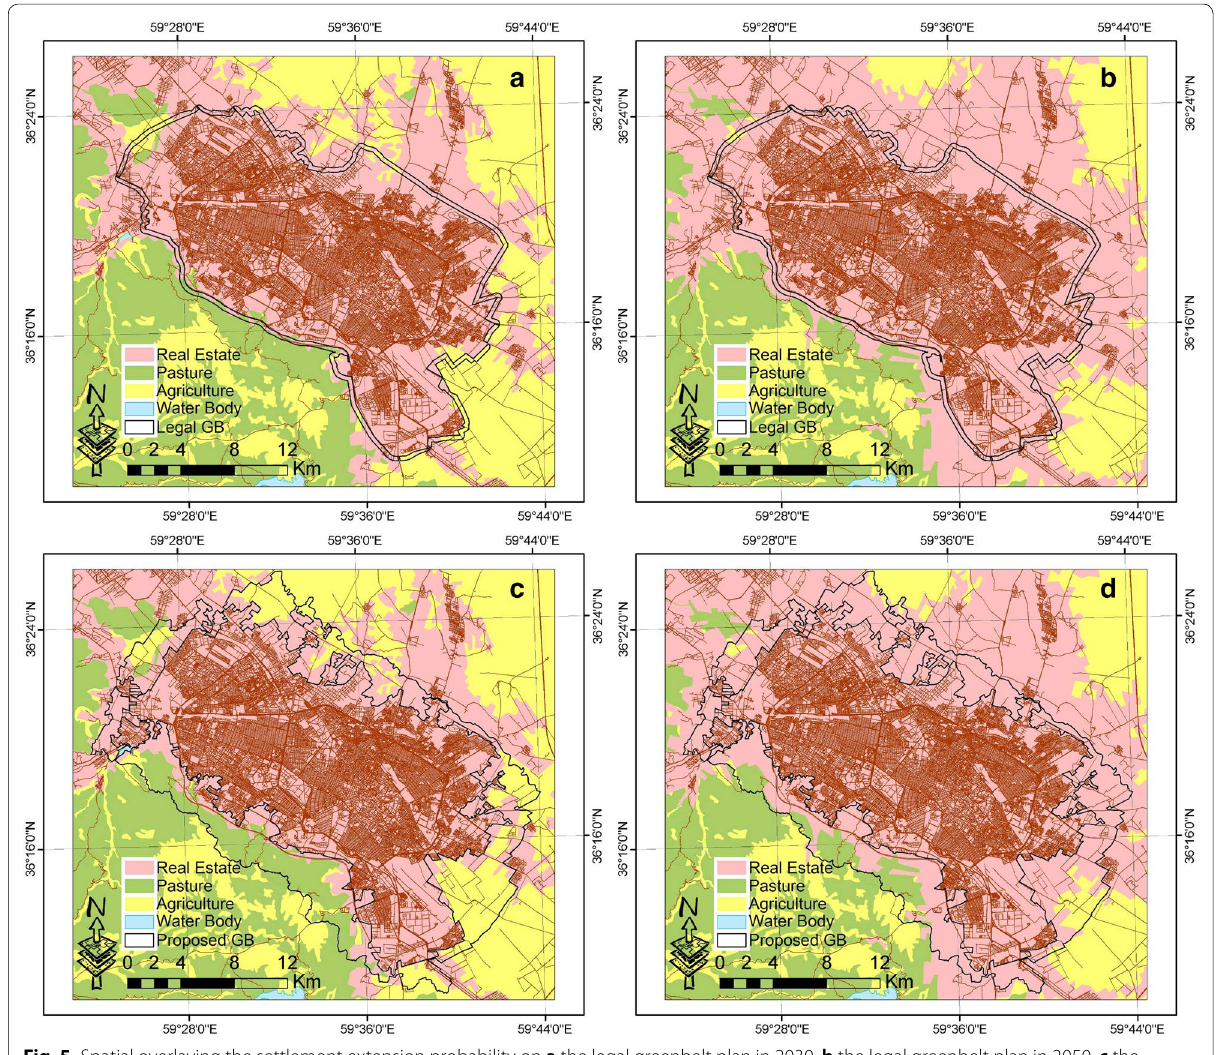
Fig. 5 Spatial overlaying the settlement extension probability on a the legal greenbelt plan in 2030, b the legal greenbelt plan in 2050, c the proposed greenbelt plan 2030, and d the proposed greenbelt plan in 2050